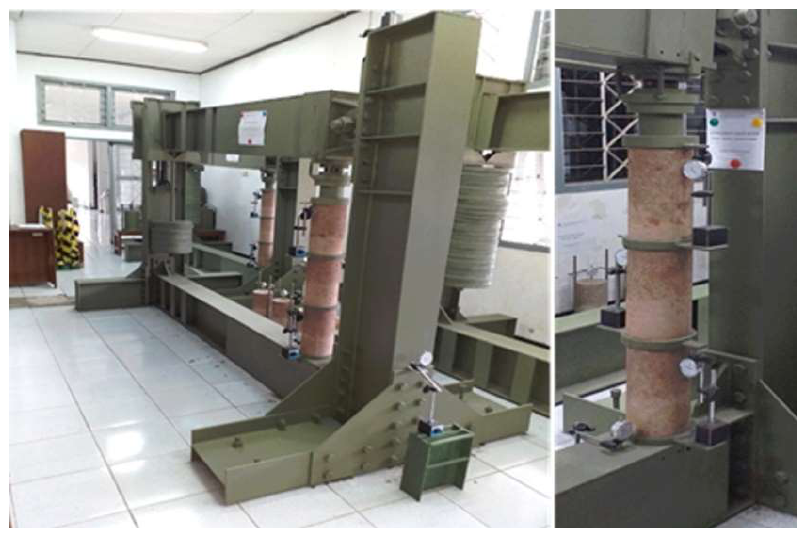
Figure 3. Setup for creep test.